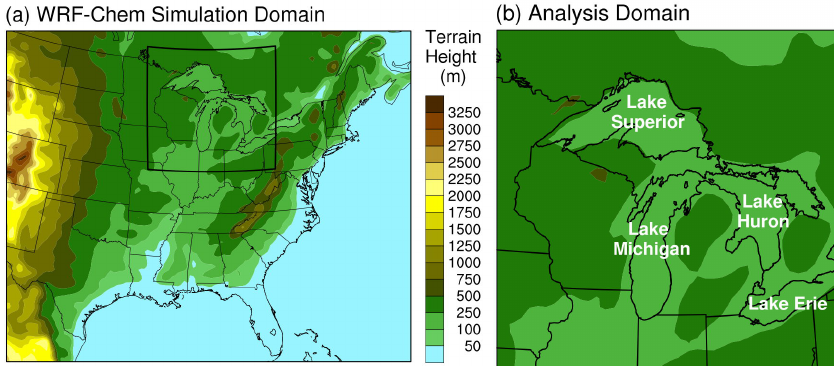
Fig. 1. (a) Terrain height (m) of the WRF-Chem simulation domain and (b) analysis domain focusing on the Great Lakes region.